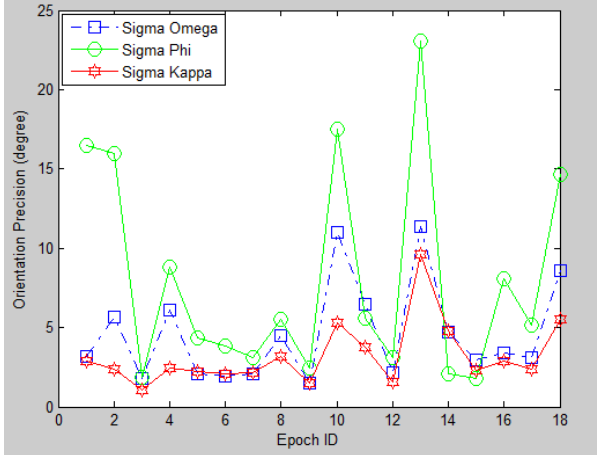
Figure 21. Orientation precision for the 18